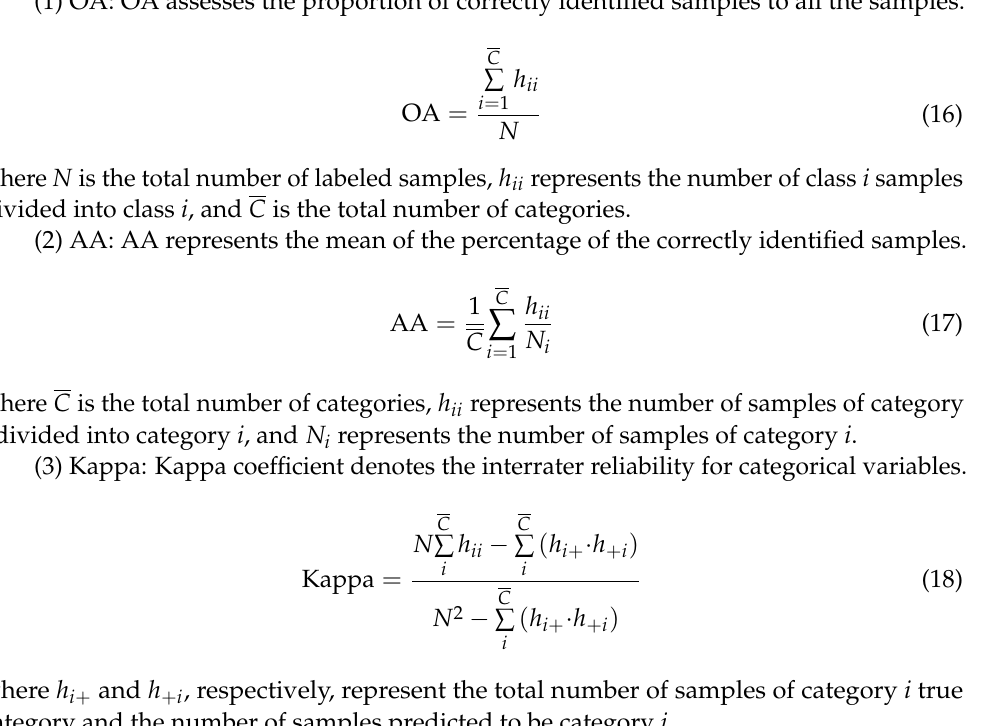
Table 2. Land cover types and total number of samples in the PaviaU dataset. 10,249